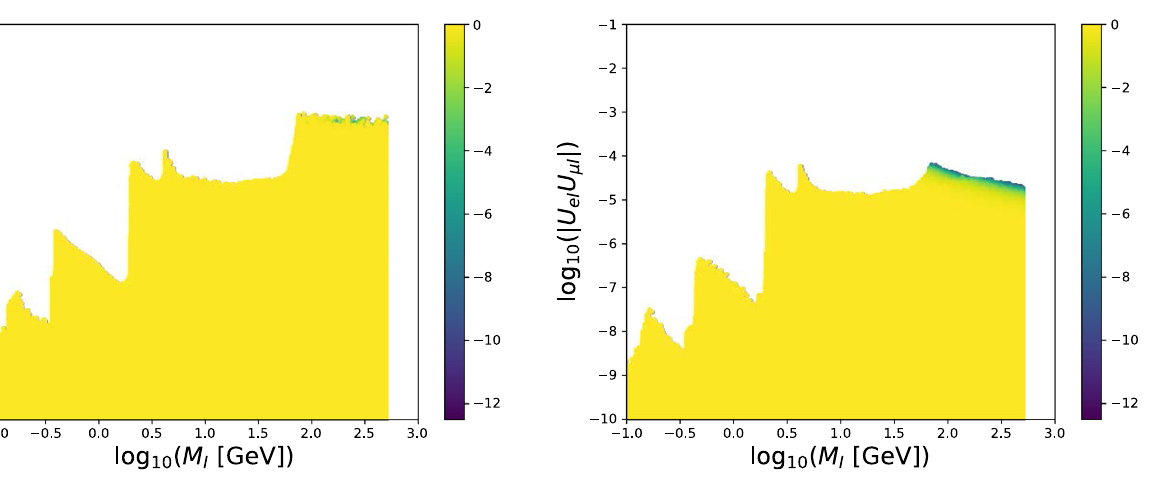
Fig. 32 Partial likelihood from lepton flavour violating decays μ →